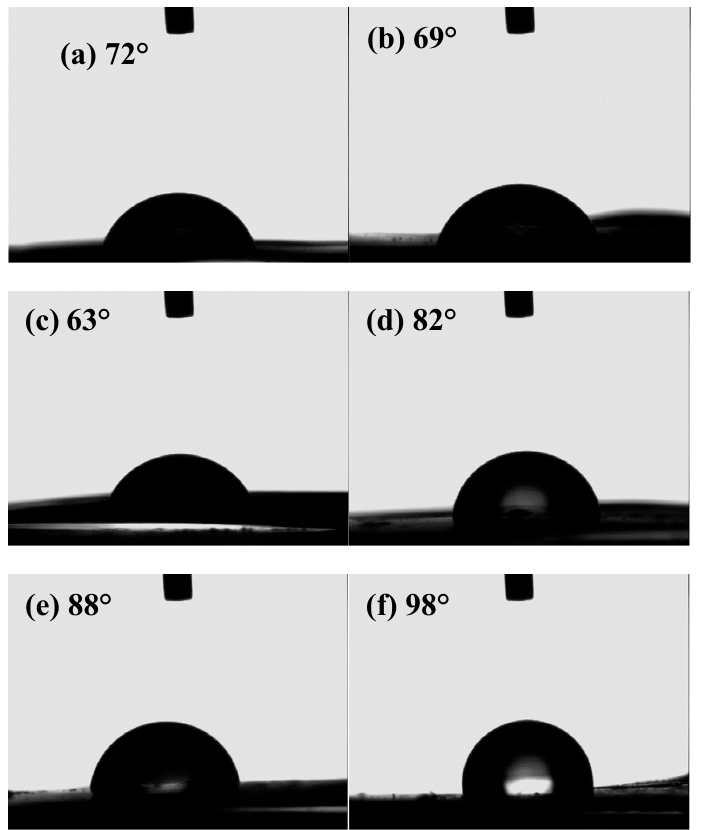
Figure 1. Pictures of water droplets on chitosan/magadiite (CS/MAG) ( a – c ) and CS/KH550/MAG ( d – f ) membranes with different mass proportion for contact angle. (a,d), (b,e), (c,f) for CS:MAG = 9:1; 7:3; 5:5, respectively.